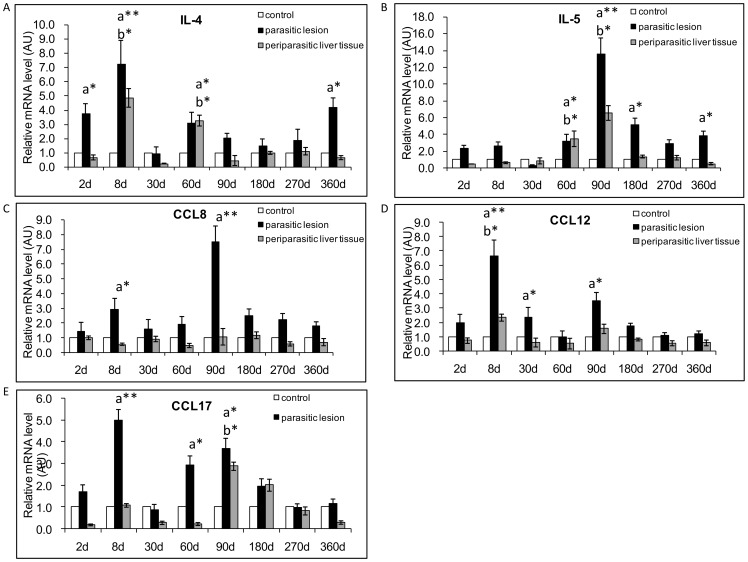
Course of Th2-cytokine and related chemokine gene expression in the liver of mice during E. multilocularis infection (measured by q RT-PCR).(A) IL-4, (B) IL-5, (C) CCL8, (D) CCL12, (E) CCL17. a: ‘Parasitic lesion’ versus ‘Control’; b: ‘Periparasitic Liver tissue’ versus ‘Control’. *P<0.05; **P<0.01. ‘Control’, non-infected mice; ‘Parasitic lesion’: E. multilocularis metacestode and surrounding immune infiltrate; ‘Periparasitic liver tissue: liver parenchyma close to the E. multilocularis lesion, but excluding macroscopically visible liver tissue alterations. AU: arbitrary units.